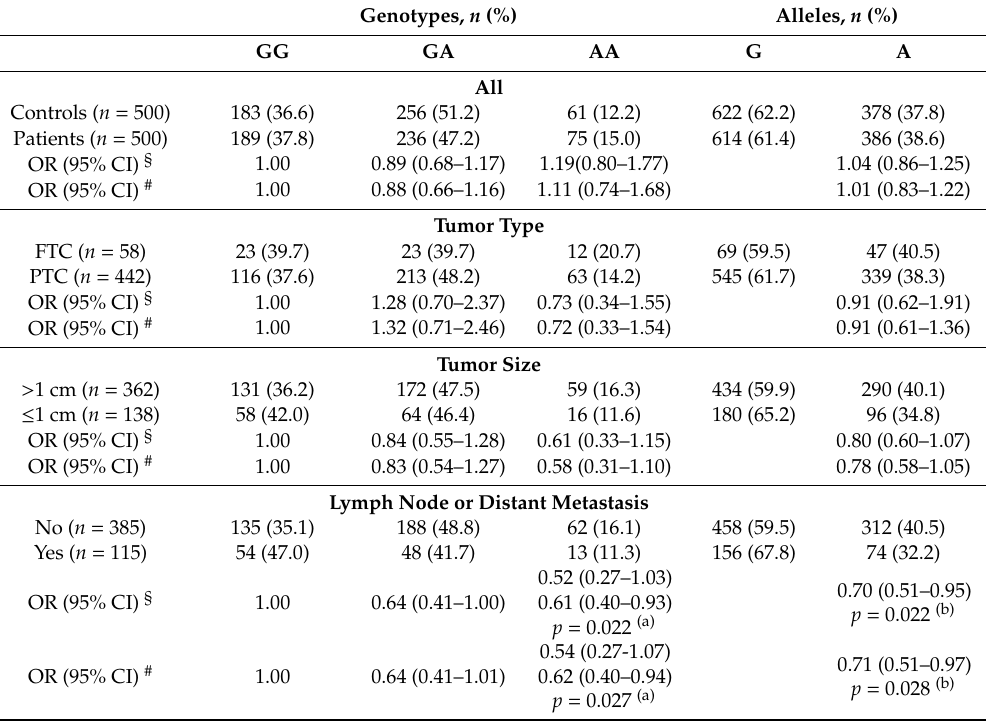
Table 2. Analysis of CYP2R1 rs2060793 genotype and allele